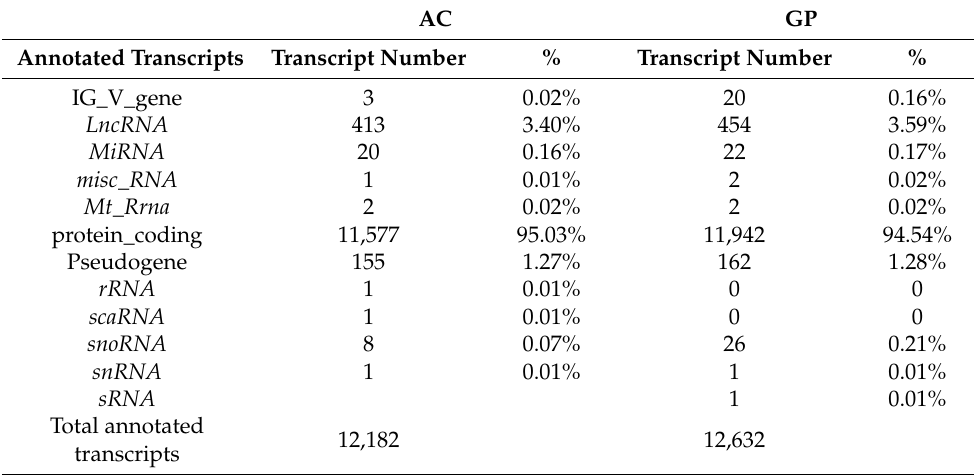
Table 2. Characterization of the transcripts identified in the articular cartilage (AC) and femoral growth plate (GP)